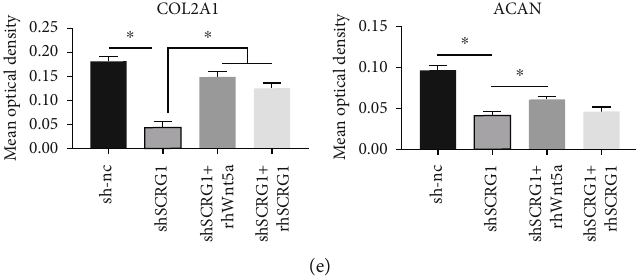
Figure 5: SCRG1 regulated chondrogenesis of UCMSCs through Wnt5a signaling pathway. (a) Regulating pluripotency of stem cell signaling pathway was the most signi fi cantly enriched KEGG pathway based on GSEA, wnt5a was negatively correlated with this pathway after SCRG1 overexpression. (b, c) Western blot analysis showed that Wnt5a decreased after shSCRG1 transfection and was restored after administration of rhSCRG1 (450ng/mL); protein levels of β -catenin exhibited the opposite trend to Wnt5a. (d, e) Protein levels of COL2A1 and ACAN were detected in UCMSCs by IHC. The results showed that the protein levels of COL2A1 and ACAN were reduced following SCRG1 knockdown and restored after treated with rhWnt5a (300ng/mL) and rhSCRG1 (450ng/mL) protein at 24h. Scale bar = 100 μ m . Experiments were repeated three times, ∗ P < 0 : 05 ( t